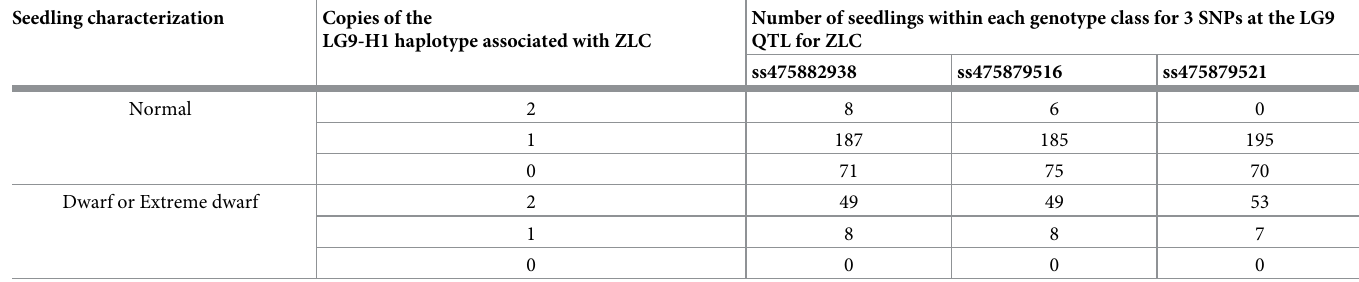
Table 2. Number of seedlings from a ‘Minneiska’ x ‘MN55’ cross observed in each genotype class for 3 SNPs in the LG9 ZLC QTL and in normal and dwarf pheno- type classes in 2018. Seedling